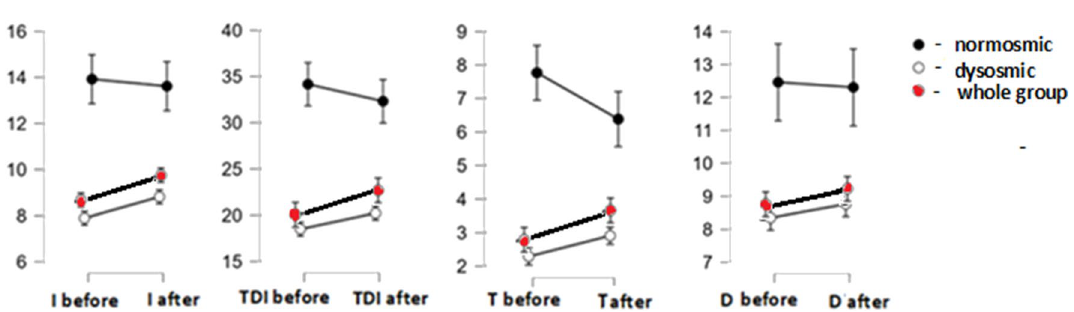
Figure 2. Improvement in general olfactory function (TDI), odor threshold (T), odor identification (I), and odor discrimination (D) score in the whole group of patients (marked with red color) and in the groups